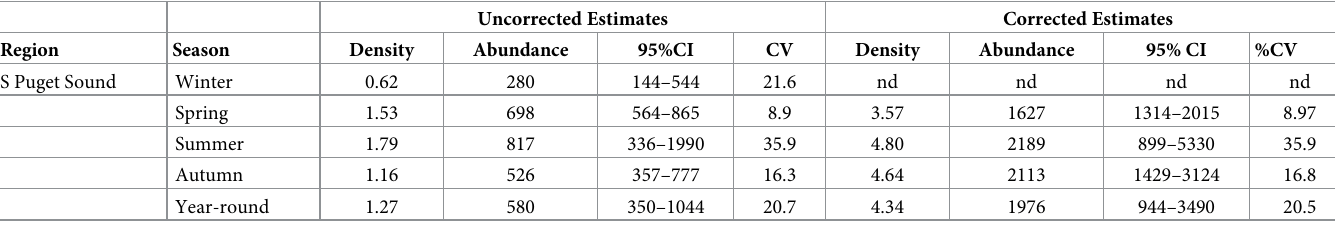
Table 3. Density and abundance estimates for inland Washington harbor seals, Southern Puget